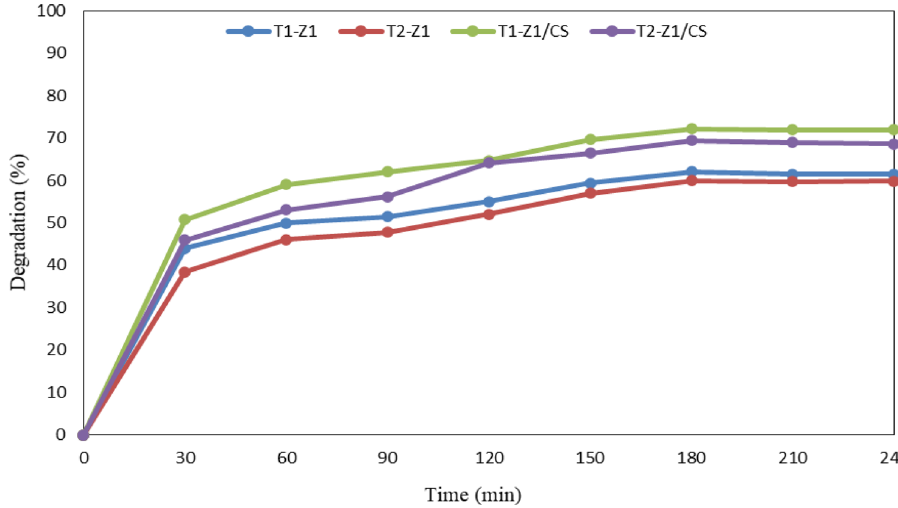
Figure 7. Photocatalytic activity of binary and ternary nanocomposites over time.